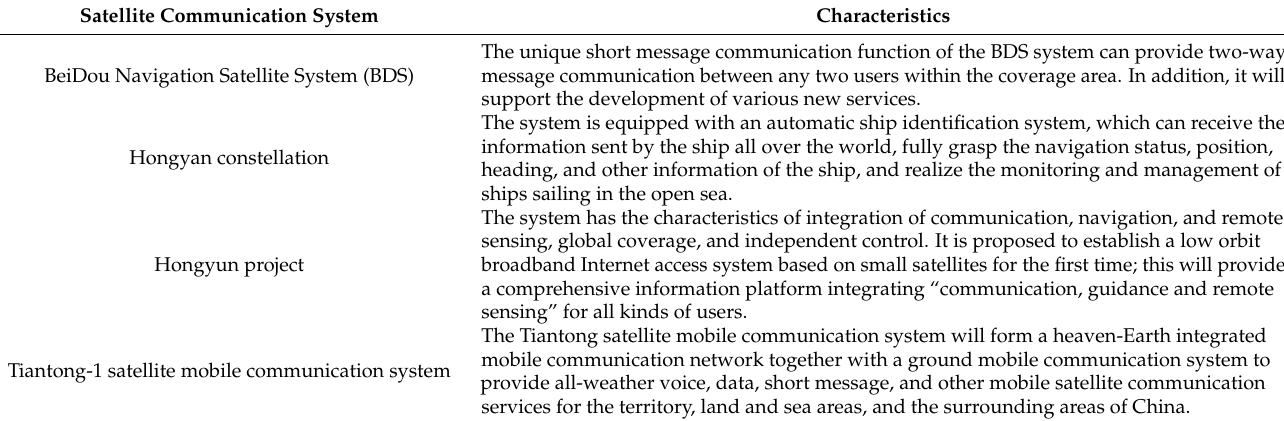
Table 5. Representative domestic satellite communication